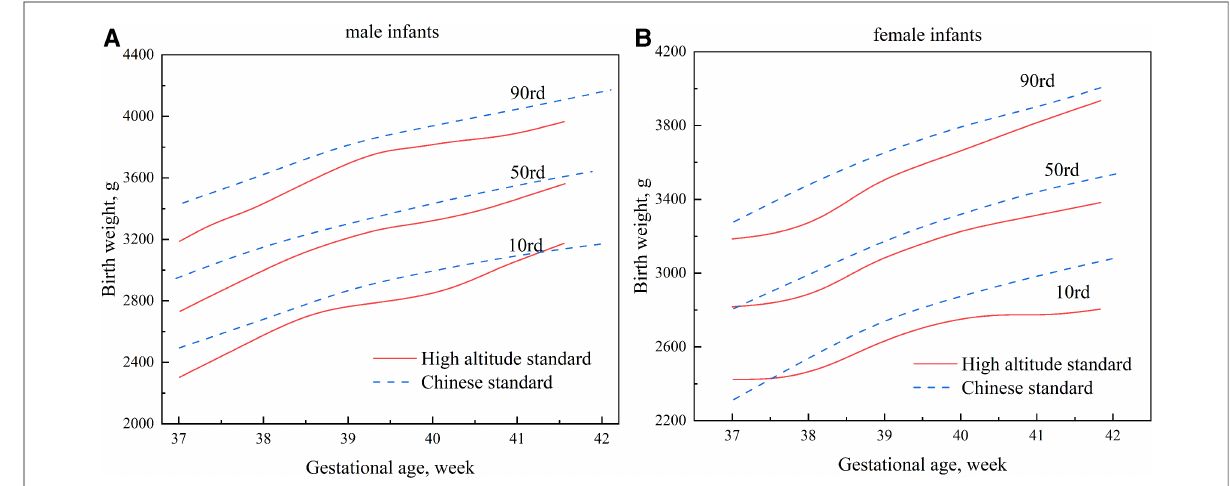
FIGURE 4 Comparisons of percentile curves of the high-altitude and Chinese standards for neonatal birth weight ( A ): male infants; ( B ): female